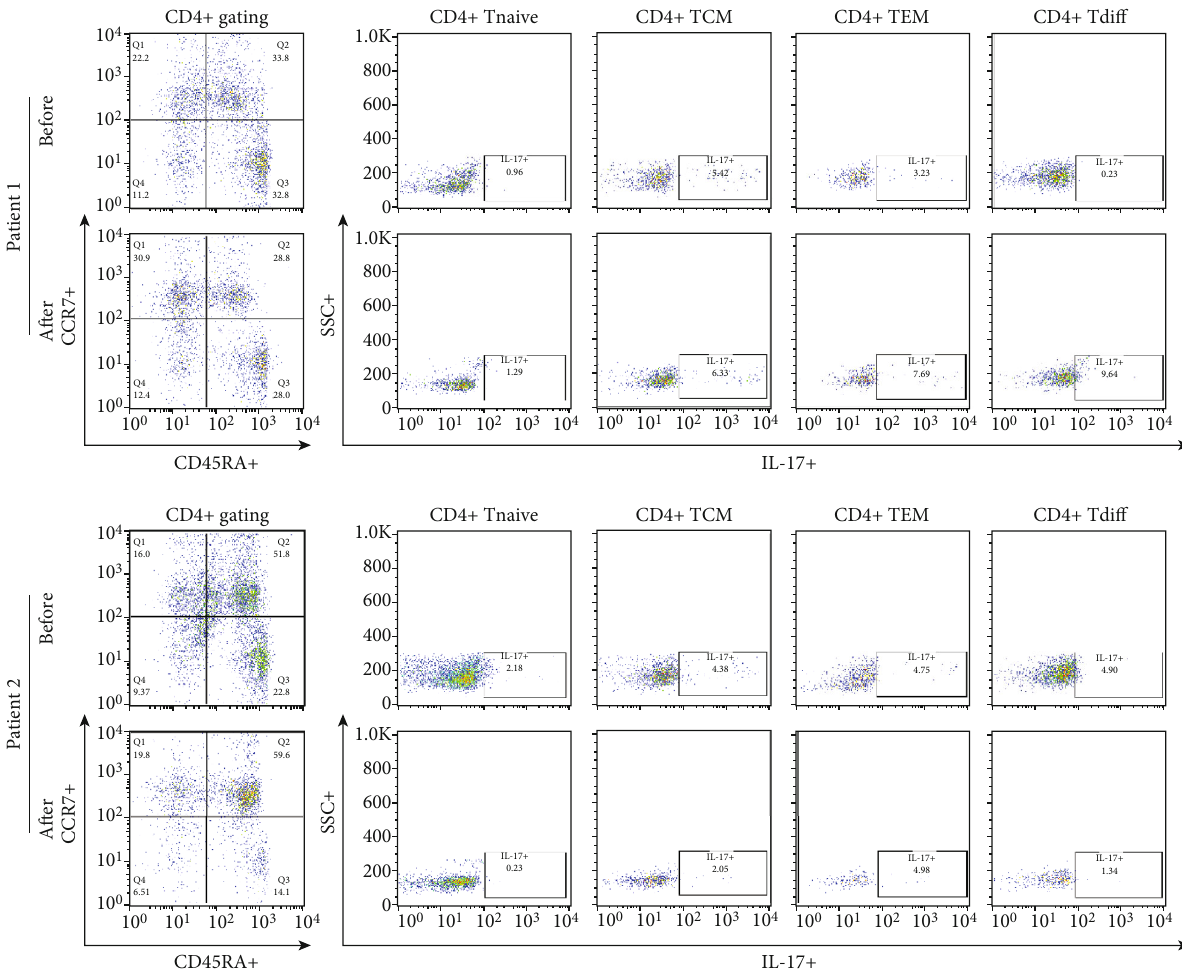
Figure 3: Comparison of CD4+ T cell subsets before and after MSC treatment. PBMCs were stained with anti-CD4 PE-Cy7-conjugated, anti- CD45RA FITC-conjugated, anti-CCR7 APC-conjugated, and anti-IL-17 PE-conjugated antibodies. CD4+ T cells were gated for further analysis. The proportions (%) of CD4+ T cells/lymphocytes, CD4+ Tnaive (CD45RA+ CCR7+/CD4+ T cells), CD4+ TCM (CD45RA- CCR7+/CD4+ T cells), CD4+ TEM (CD45RA-CCR7-/CD4+ T cells), and CD4+ Tdi ff (CD45RA +CCR7-/CD4+ T cells) in each patient were determined. After surface staining with anti-CD4 PE-Cy7-conjugated, anti-CD45RA ± FITC-conjugated, and anti-CCR7 APC- conjugated antibodies, analysis of IL-17 expression in CD4+ T cell subsets by intracellular fl ow cytometry was performed. The proportions (%) of IL-17+/CD4+ Tnaive (CD45RA +CCR7+/CD4+ T cells), IL-17+/CD4+ TCM (CD45RA-CCR7+/CD8+ T cells), IL-17+/CD4+ TEM (CD45RA-CCR7-/CD4+ T cells), and IL-17+/CD4+ Tdi ff (CD45RA +CCR7-/CD4+ T cells) in each patient were determined. “ Before ” indicates the results at the start of MSC treatment, and “ After ” indicates the results at 3 months after the fi nal MSC infusion. MSCs: mesenchymal stem cells; PBMCs: peripheral blood mononuclear